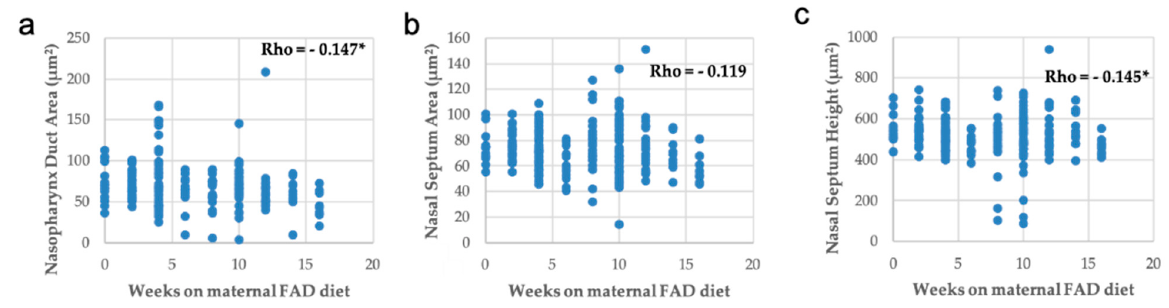
Figure 9. Correlations between nasal measurements with weeks on maternal FAD diet. ( a ) Nasopharynx duct area, ( b ) nasal septum area and ( c ) nasal septum height. * p ≤ 0.05; Spearman’s Rho.